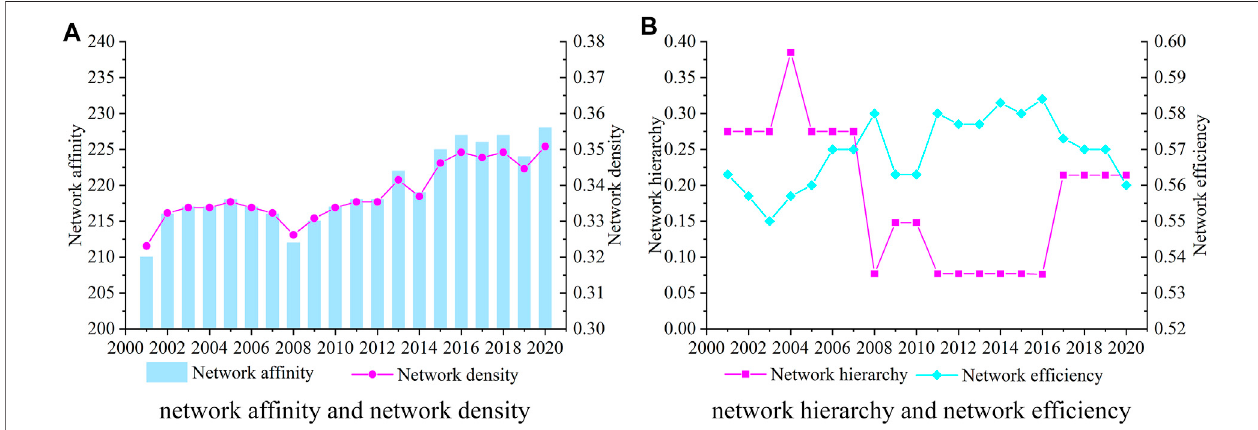
FIGURE 4 | Overall network characteristics of the water network in the YRDUA. (A) network af fi nity and network density. (B) network hierarchy and network ef fi